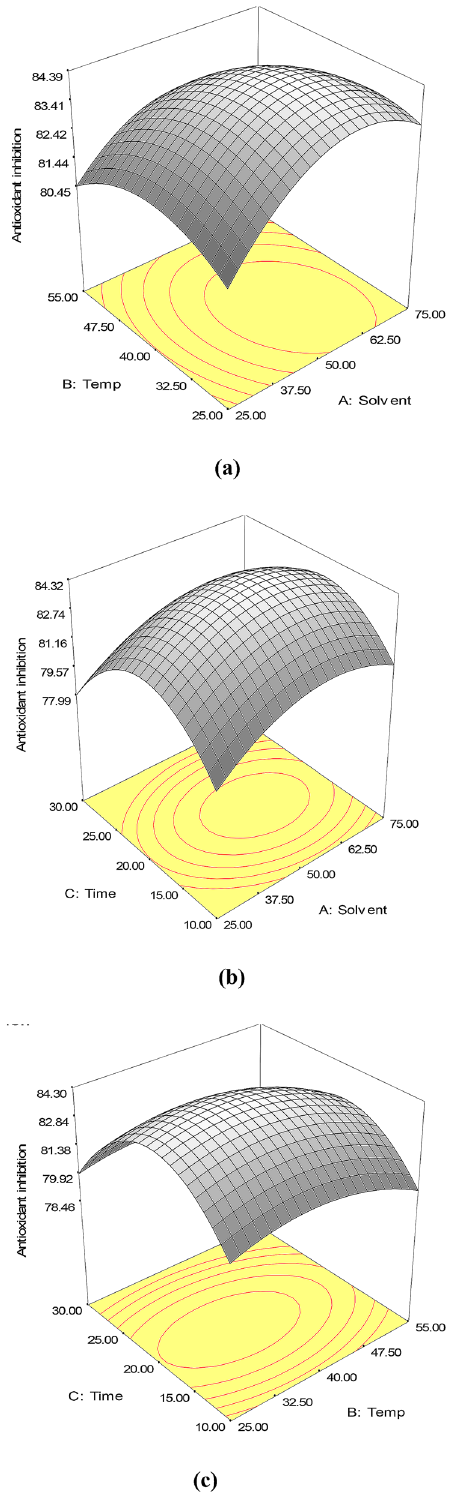
Figure 6. Response surface plots showing the effects of extraction parameters on the DPPH of the extracts from fruits of F. auriculata . ( a ) The constant ultrasonic time (20 min), ( b ) the constant temperature (40 °C), and ( c ) the constant ethanol concentration